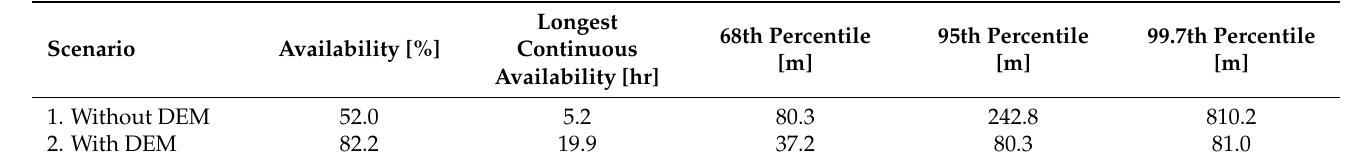
Table 9. Statistics highlighting the gain in performance when using a DEM. The percentiles refer to the time series of the horizontal uncertainty (3-sigma).